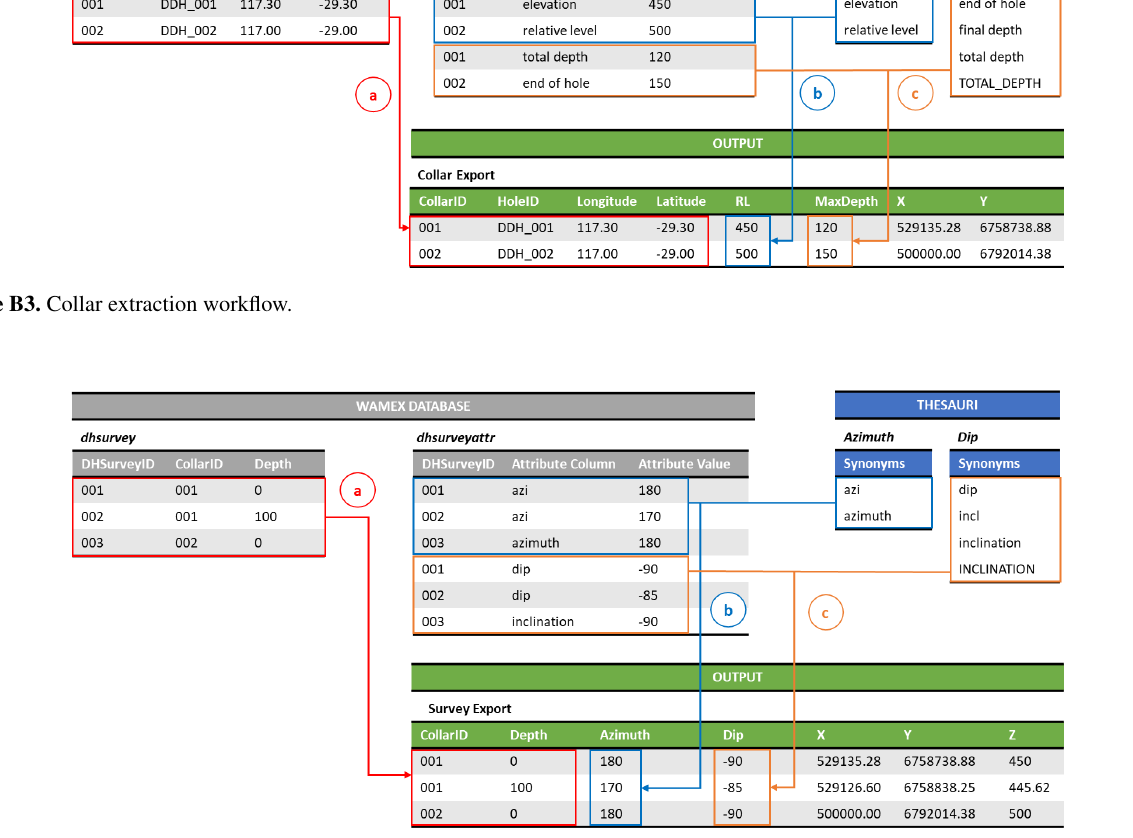
Figure B4. Survey extraction